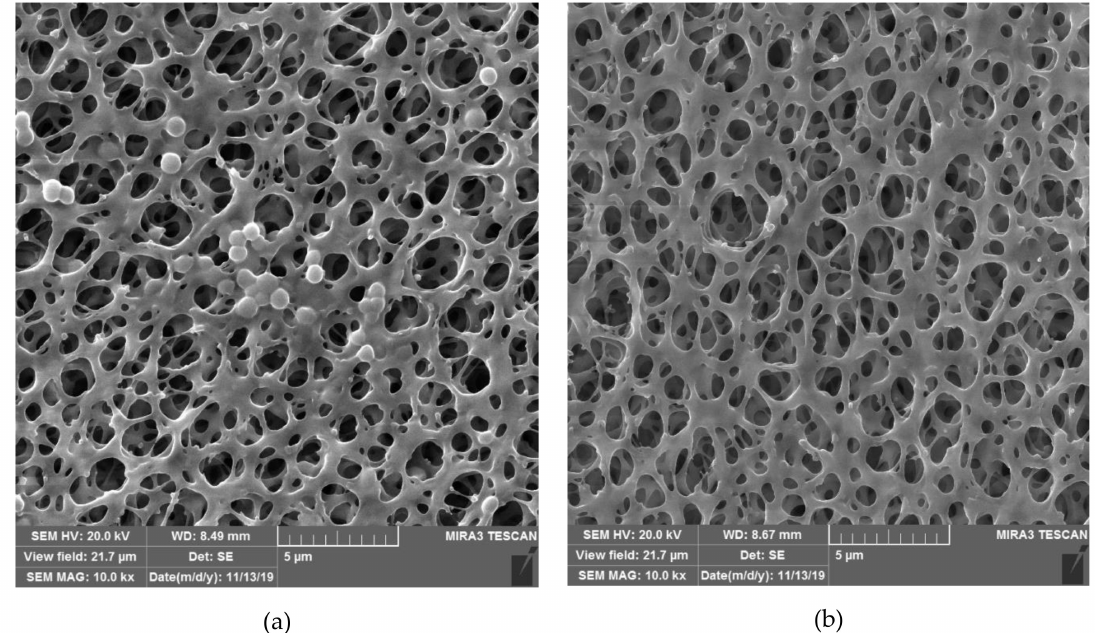
Figure 3. SEM images of the neat cellulose acetate-based polymer ( a ), and the cellulose acetate-based polymer loaded with thymol ( b ), after the exposure to S. aureus